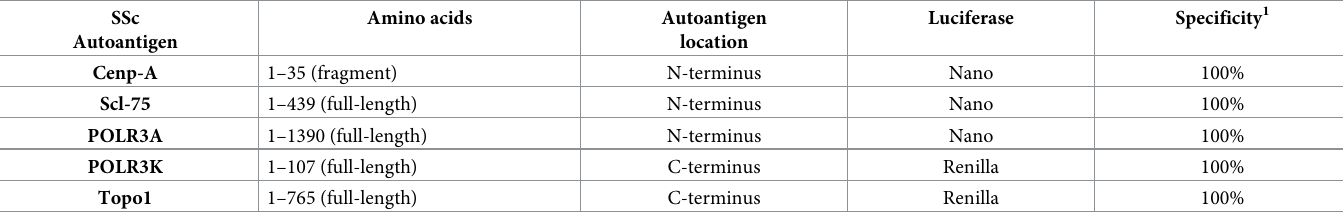
Table 2. Characteristics and specificity of luciferase-SSc autoantigen